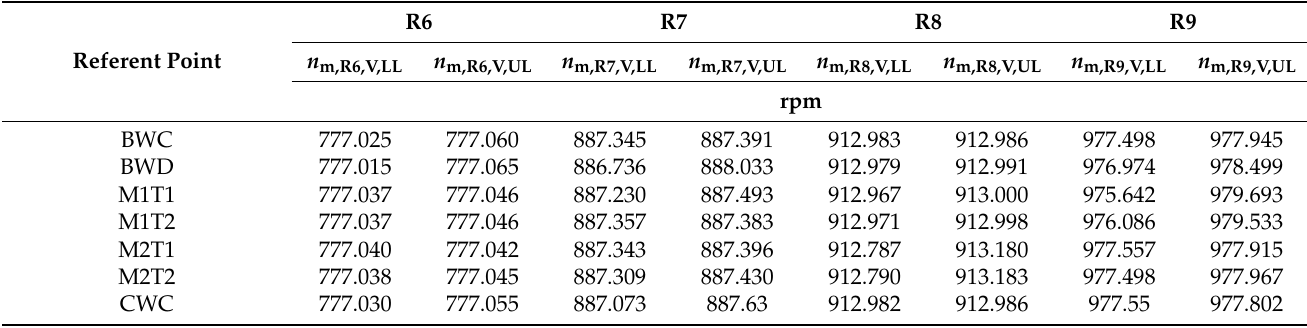
Table 9. Boundaries of the FREM resonant domains according to a V,per –EHO: 3.